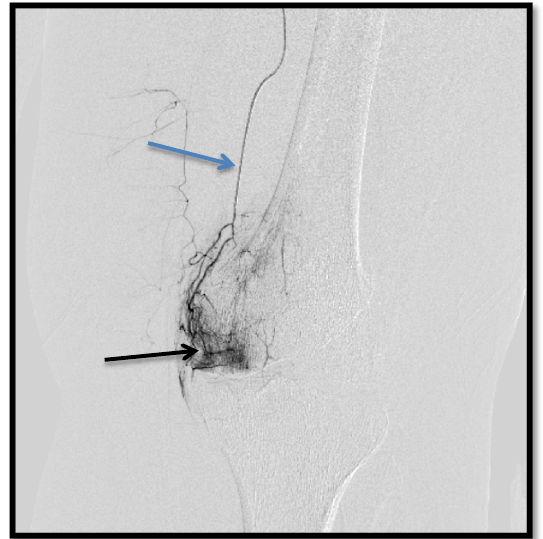
Fig. 2 Angiography of the descending genicular artery (blue arrow) shows hyper-vascular inflammatory “ blush ” (black arrow) over the medial aspect of the knee